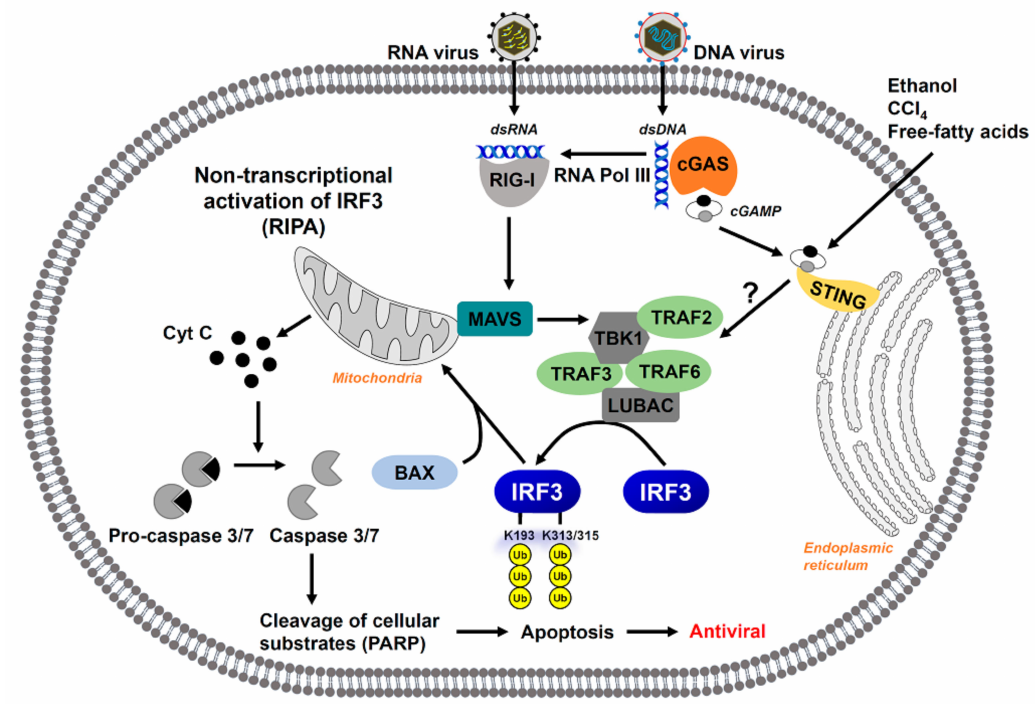
Figure 2. The non-transcriptional activation of IRF3 by RIPA causes cell death. IRF3 can be activated by RNA or DNA virus infection, which triggers RIG-I or cGAS signaling pathways. The RIG-I activation by RNA or DNA viruses can recruit a complex by TBK1/TRAF2/TRAF6, which allows the binding of IRF3 to LUBAC. The LUBAC-mediated linear ubiquitination of IRF3 leads to its translocation to the mitochondria and interaction with BAX. Mitochondrial translocation of IRF3/BAX complex leads to cytochrome C release that activates the apoptotic caspases, leading to apoptotic cell death. This pathway has been named ‘RIPA’, which can also be triggered by ethanol, CCL4, and free fatty acids, which activate the PRR signaling